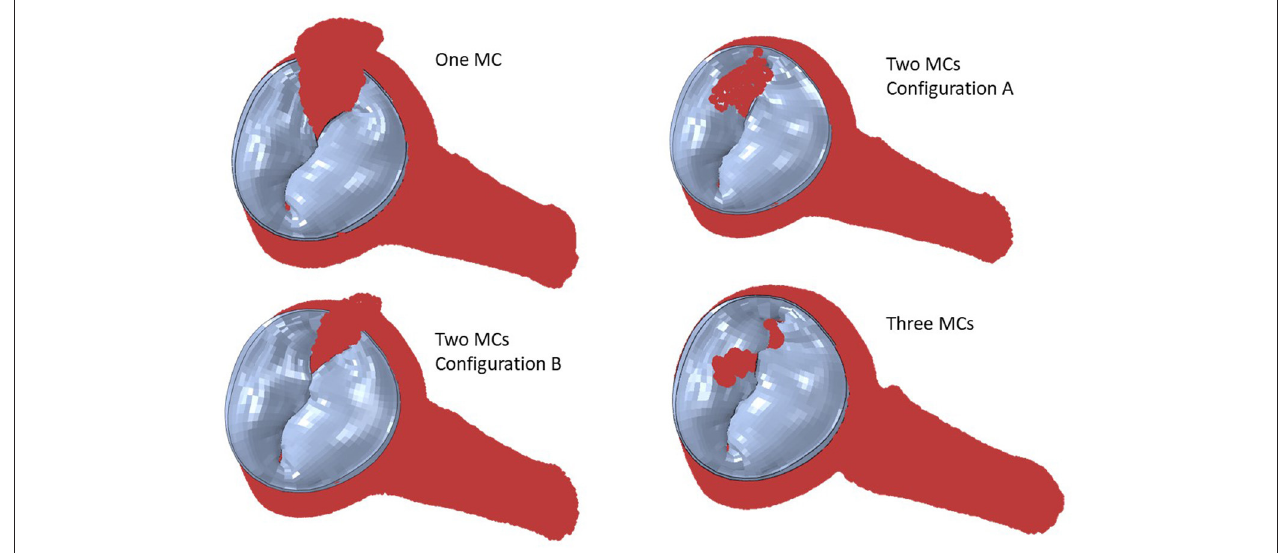
FIGURE 10 | The MR for two and three MCs. For two clips, (A) represents clips at locations 3 and 4, and (B) represents clips at locations 3 and 5.